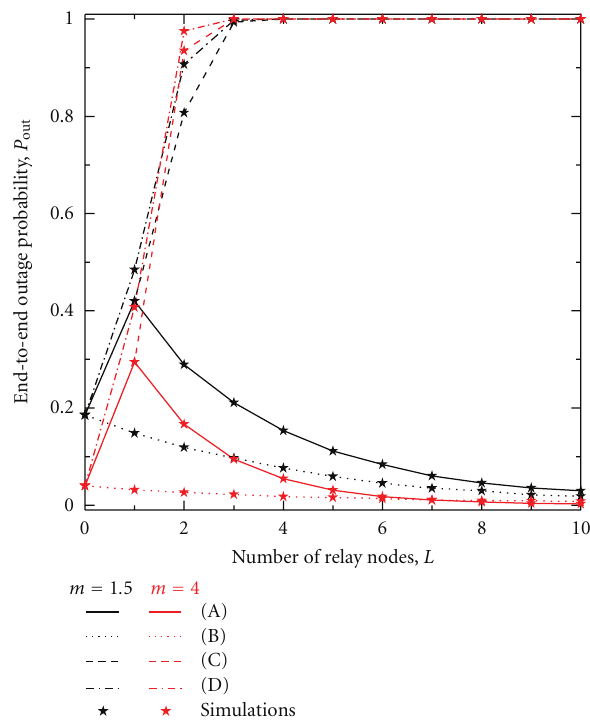
Figure 2: End-to-end OP, P out , versus the number of relay nodes, = 5dB over IID Nakagami- L , for average transmit SNR γ 0 m fading channels with di ff erent values of m : (A) pure RS, (B) rate-selective RS, (C) repetitive transmission with MRD, and (D) repetitive transmission with